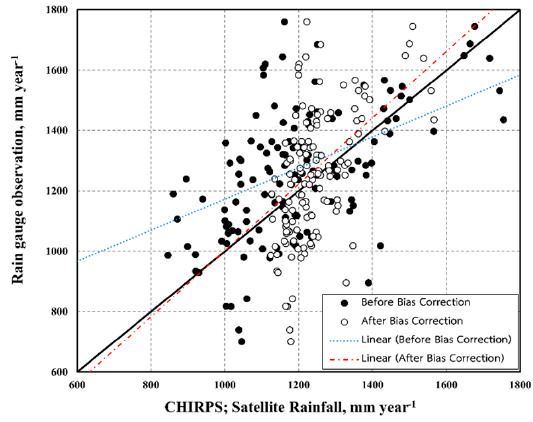
Figure 8. Annual rainfall between gauged rainfall data and the CHIRPS data (satellite-based rainfall) for before and after bias correction process.